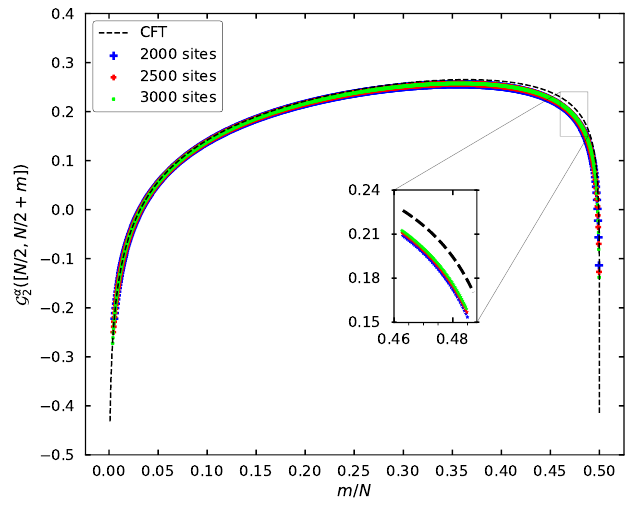
f ([ N / 2, N / 2 + m ]) for the Ising chain with 2 G